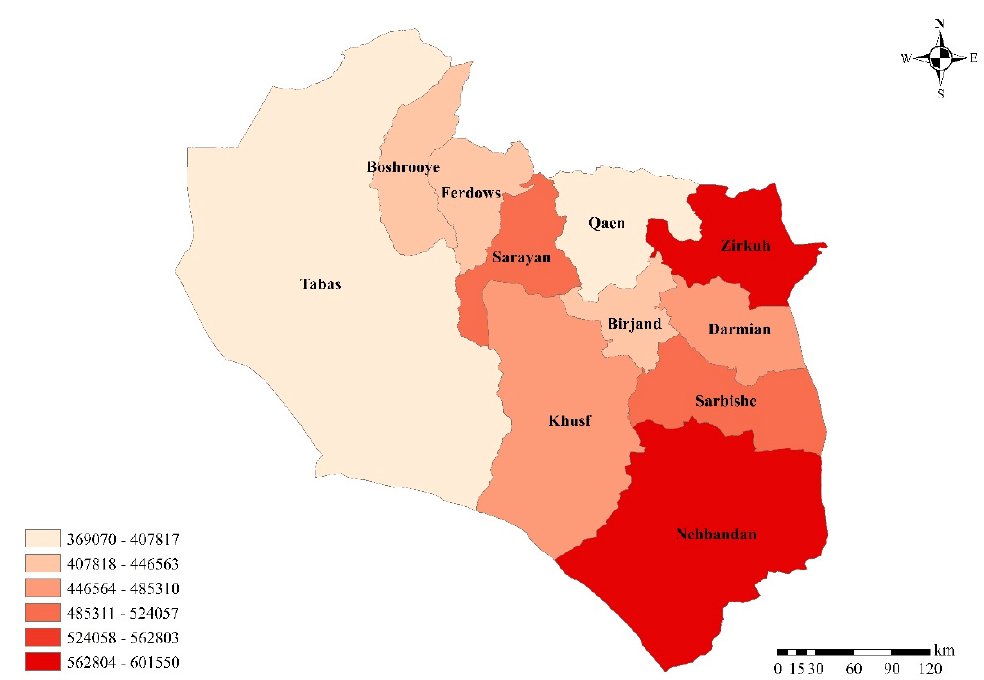
Figure 3. Evapotranspiration rate in South Khorasan province (m 3 per hectare).